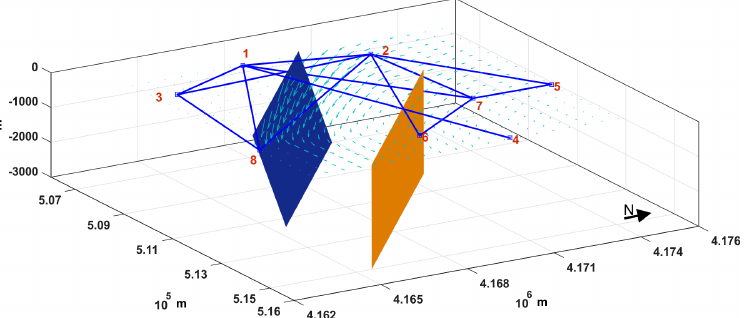
Figure 4. Location and E–W cross section of the source modeled. The arrows represent the simulated deformation field due to the estimated fault kinematics. Reference numbers as in Fig. 2.